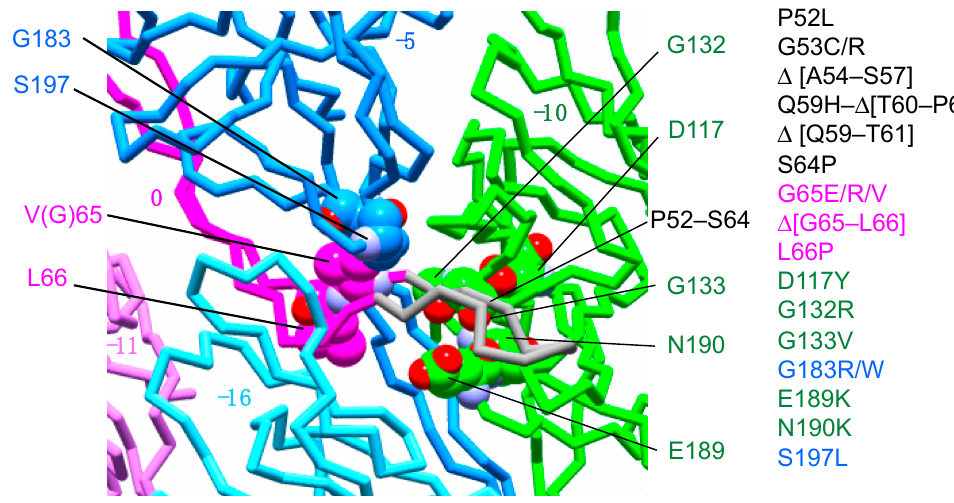
Figure 4. Polyrod mutation sites are localized around the tip of the L -stretch. The known polyrod mutation sites are mapped on the rod structure. Subunit at 0, − 5, − 10 positions are colored in magenta, blue, and green, respectively. The putative structure of the L -stretch tip of subunit 0 is shown in gray.